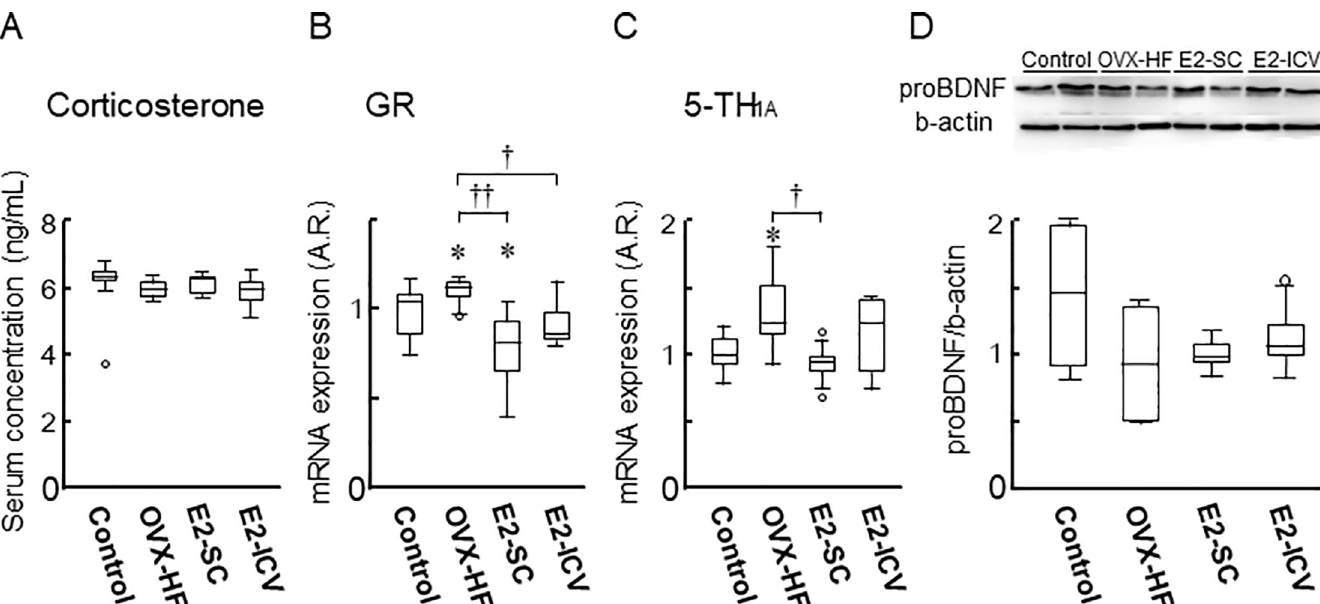
Fig 6. Biological analysis of the mice after behavioral experiments. Mice were sacrificed and samples were obtained after conducting all of the behavioral experiments. The serum corticosterone level was determined with an ELISA kit (A). Expression of GR mRNA (B) and 5-TH 1A mRNA (C) in the hippocampus was determined by real-time PCR. The level of proBDNF protein in the hippocampus was analyzed by western blotting (D). Values are the mean ± SE (n = 7-11/group). P values were determined by the two-tailed Kruskal Wallis H-test with the Mann-Whitney U-test. � P < 0.05 vs. the control group; †† p < 0.01 vs. the OVX-HF group.